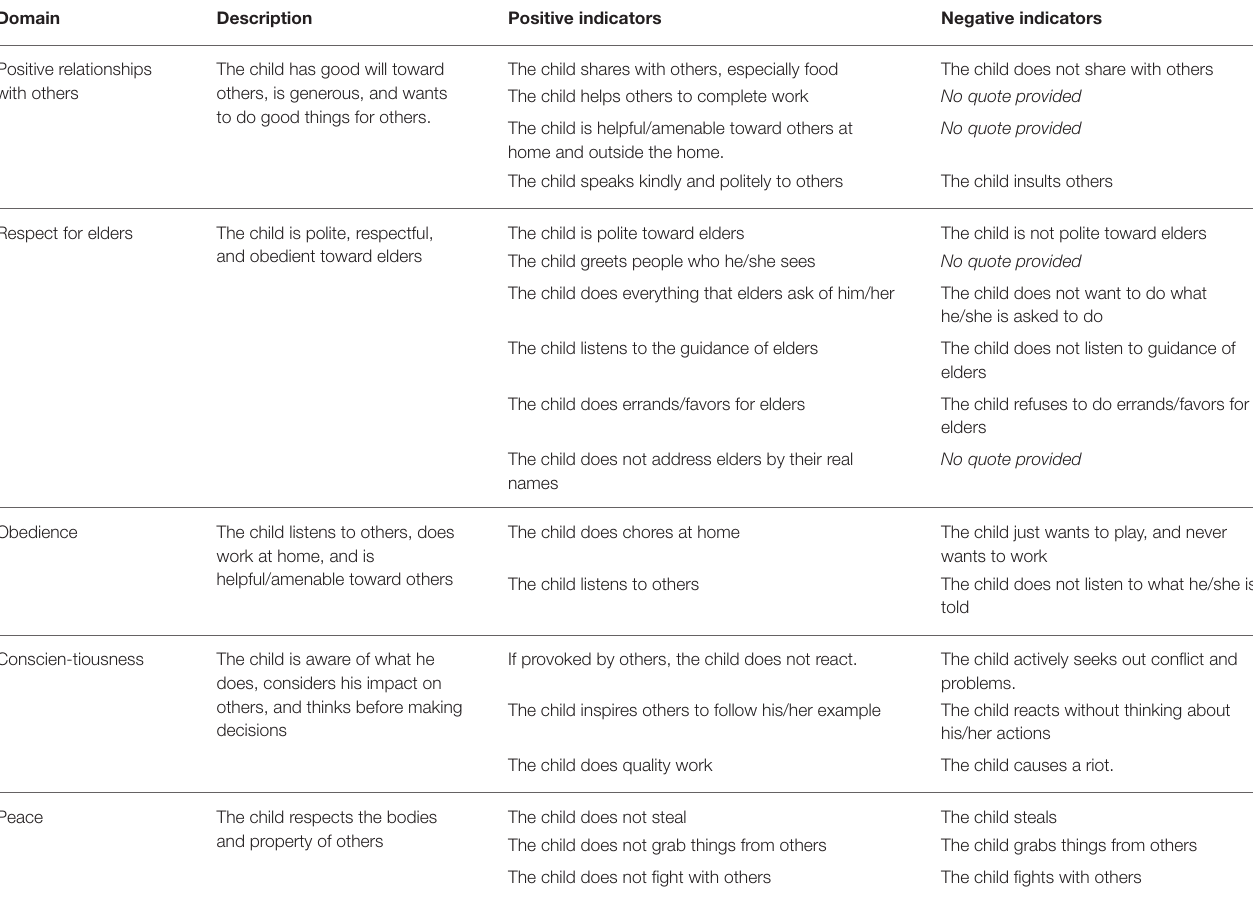
TABLE 4 | Initial Baka SEL framework domains and